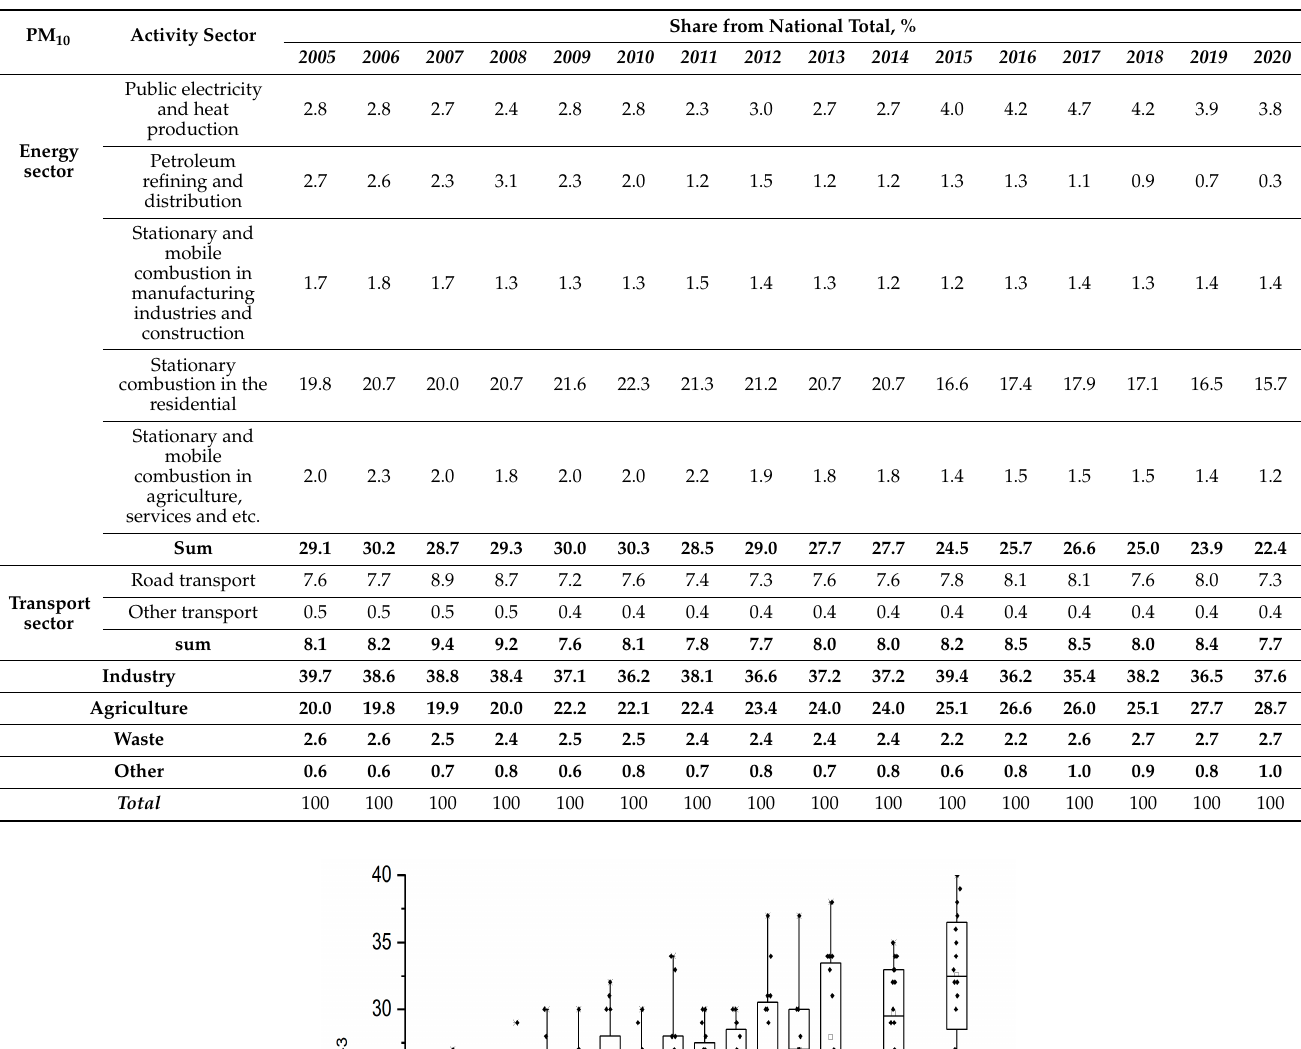
Table 3. Trend% in PM 10 emissions.